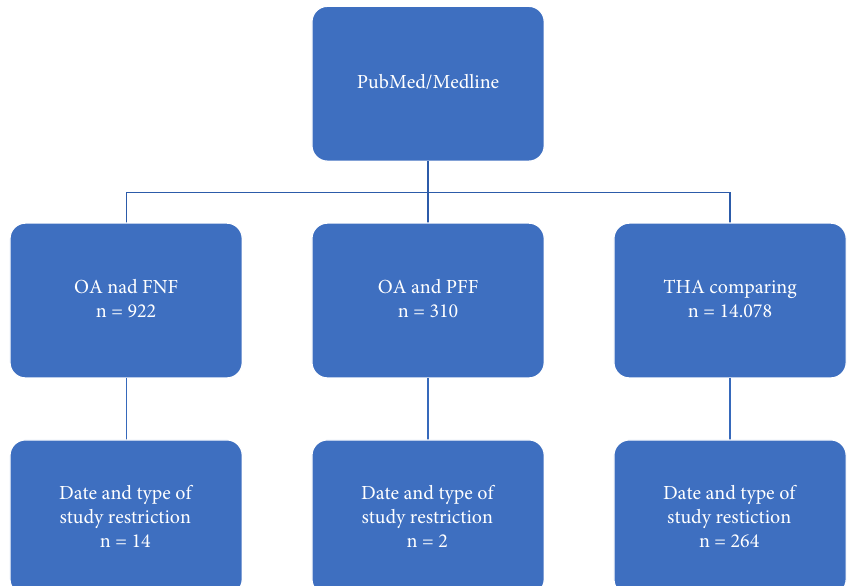
Figure 1: Results of scientific research findings based on the used phrase. OA: osteoarthrosis; FNF: femoral neck fracture; PFF: proximal femur fracture; THA: total hip